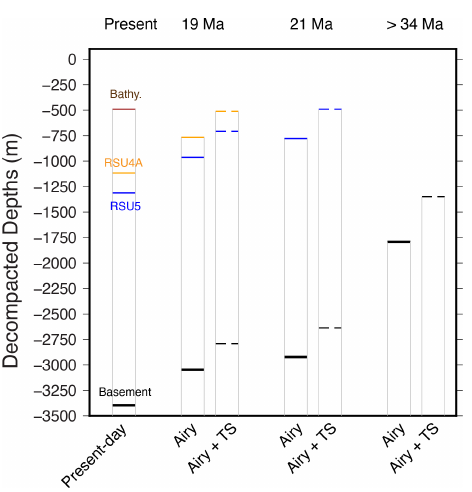
Figure 8. Backtracking steps for the western Ross Sea DSDP 273 well site. Present-day depths of the basement (black), Ross Sea unconformity 5 (blue), Ross Sea Unconformity 4A (orange), and bathymetry (brown) at the time of RSU4A (19Ma), RSU5 (21Ma), and at the time before glacial sediment deposition ( > 34Ma). For each time step, two backtracking are shown, one accounting for Airy isostatic correction only and one accounting for Airy iso- static correction and thermal subsidence (dashed). Physical param- eter values used are displayed in Table A1 in Appendix A.